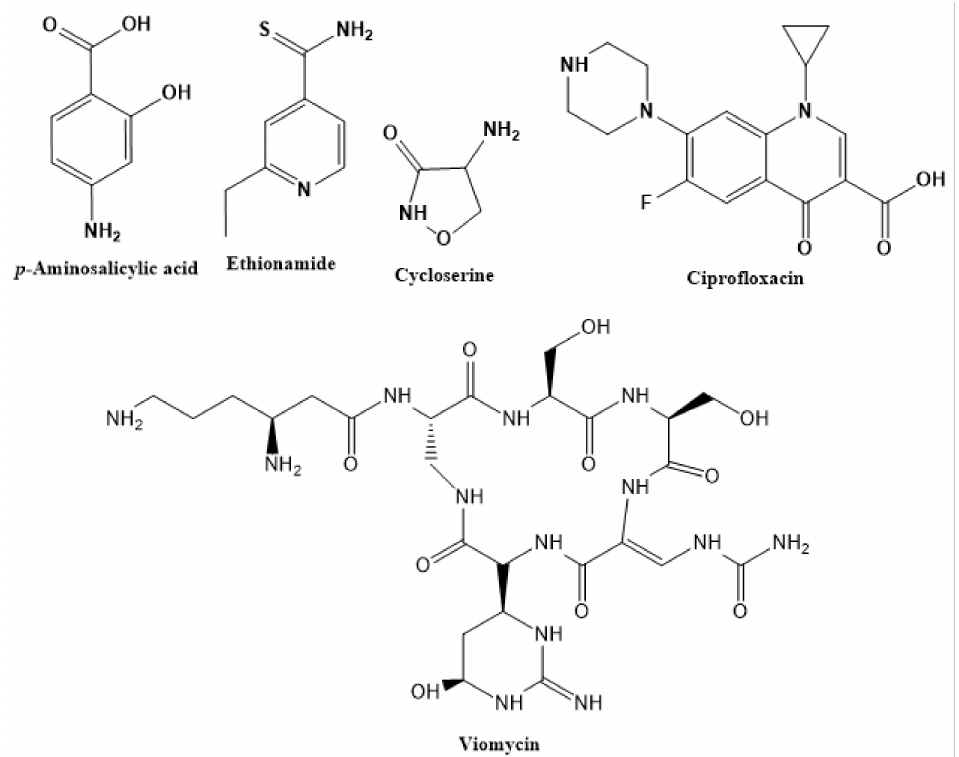
Figure 4. Chemical structures of second-line drugs used in management of